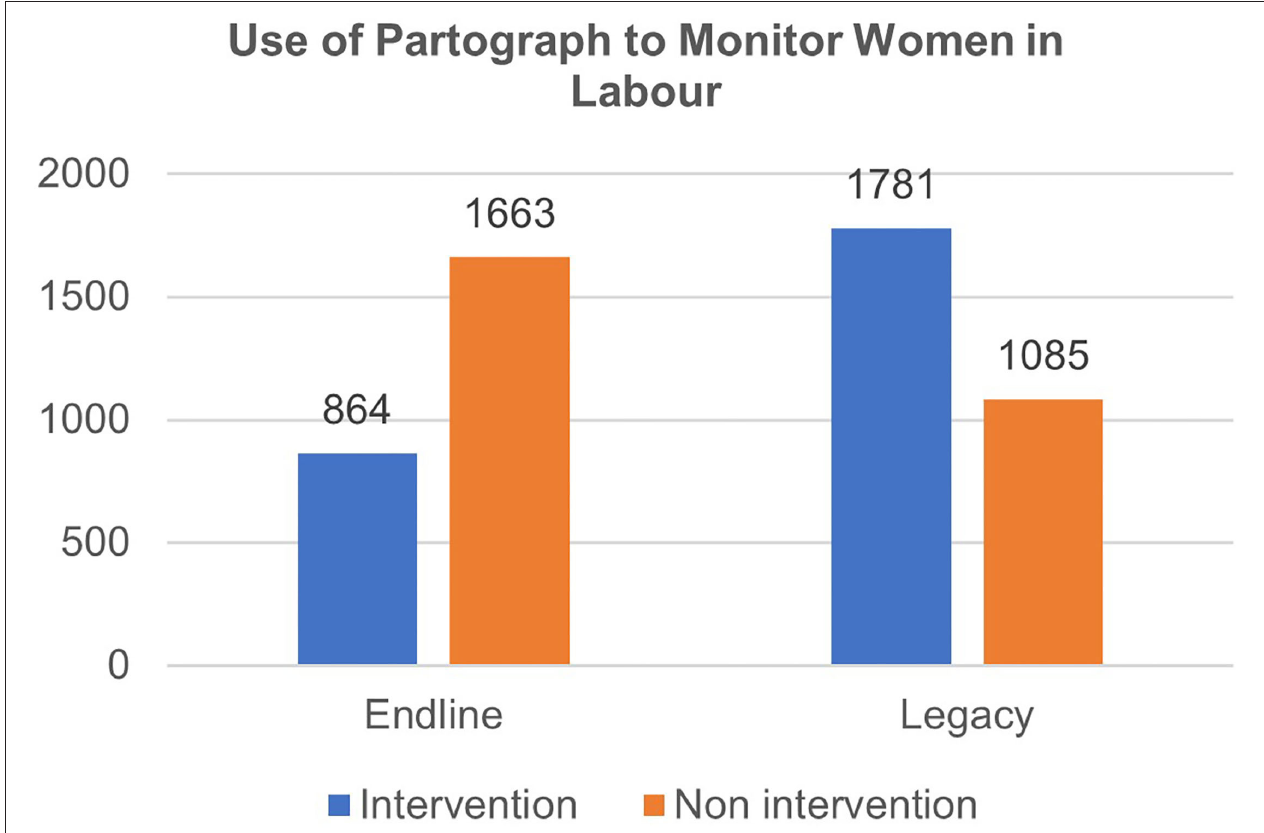
FIGURE 2 | The use of partogram to monitor labor at end-line and legacy